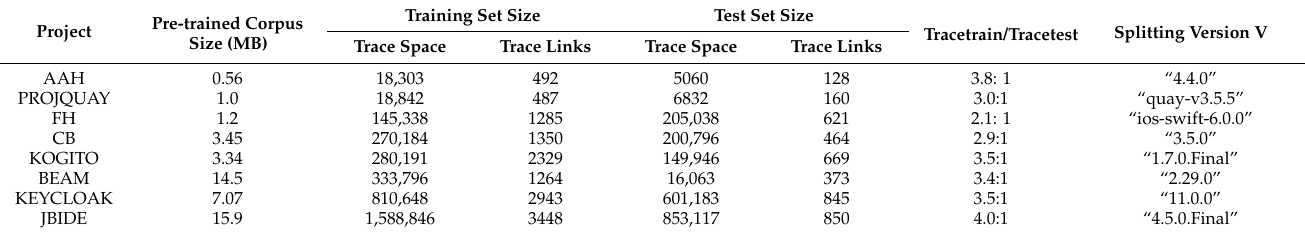
Table 3. Dataset size of each project in the DRAFT verification